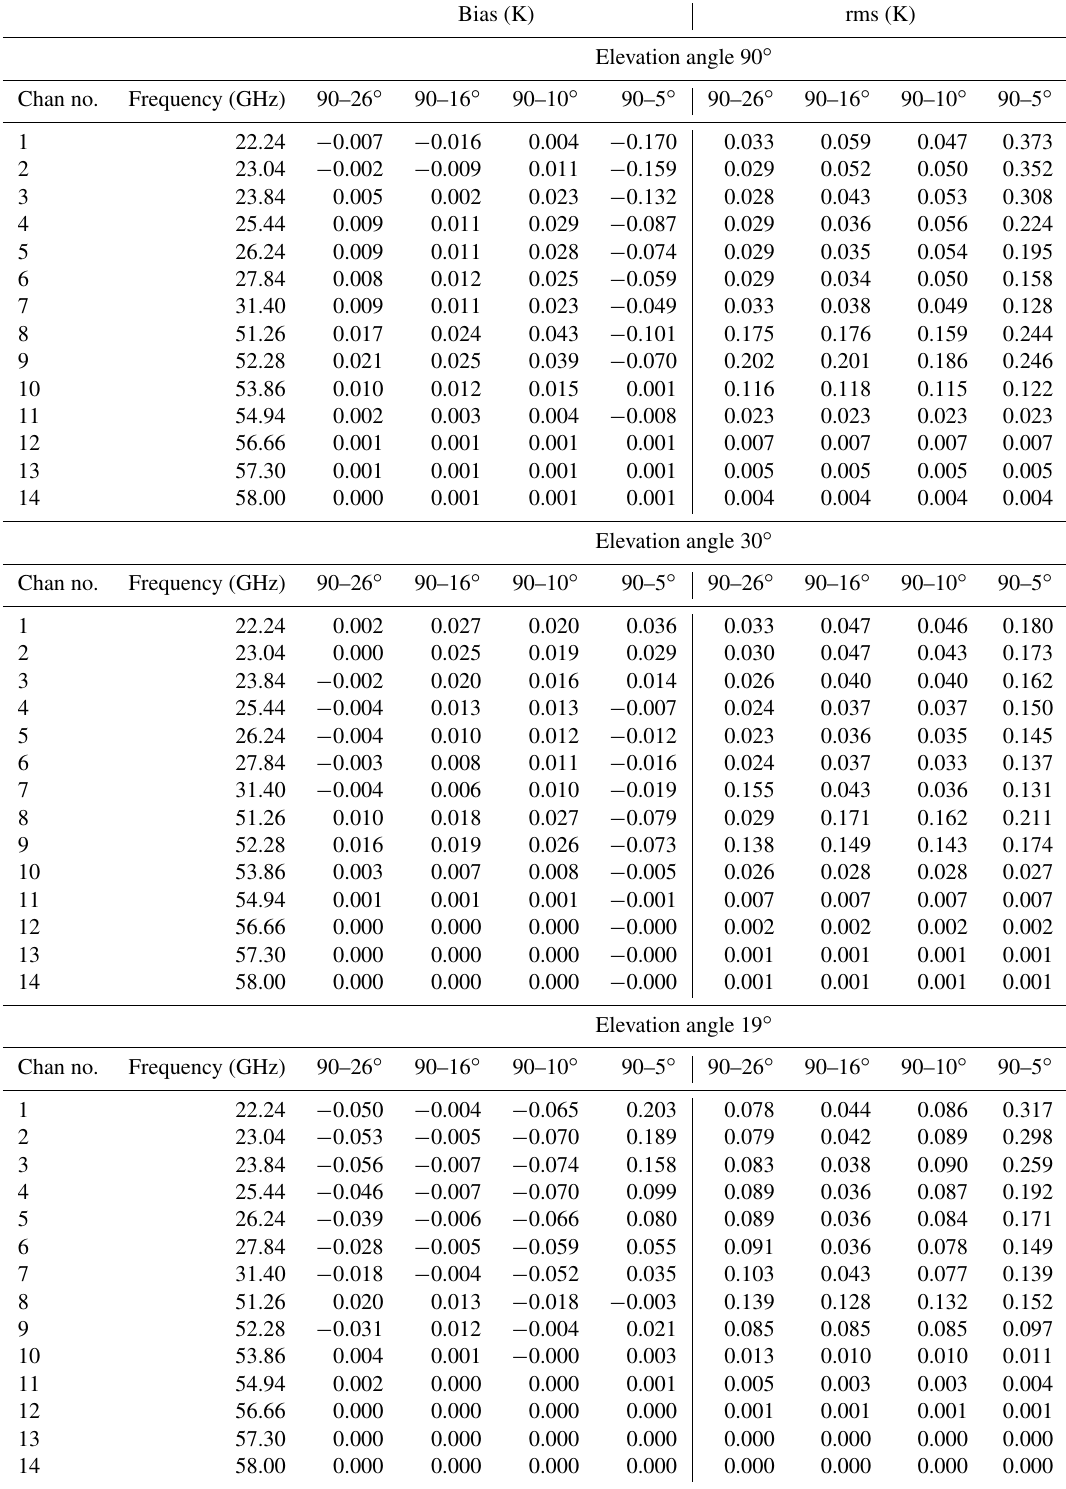
Table 1. Statistics for the comparison between RTTOV-gb and the line-by-line model R98 (Rosenkranz, 1998) at elevation angles 90, 30, 19, and 10 ◦ (R98 minus RTTOV-gb). The HATPRO channel number (Chan no.), the channel central frequency, bias, and rms for each RTTOV training configuration are reported. The values which are larger than 0.5K are highlighted in